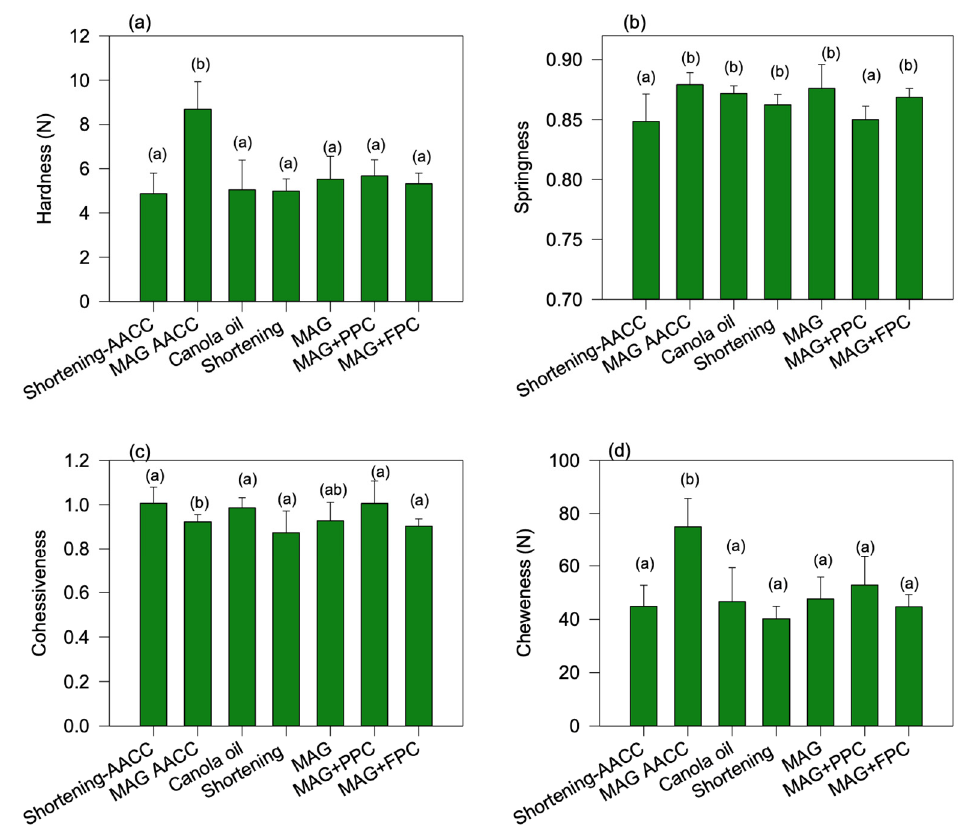
Figure 10. Texture analysis of different cakes measured 24 h after baking at room temperature: ( a ) hardness, ( b ) springiness, ( c ) cohesiveness, and ( d ) chewiness of cakes prepared using various fats with either AACC or the new lab-developed method. AACC method: Shortening-AACC, MAG oleofoam-AACC. The new lab-developed method: canola oil, shortening oleofoam, 3%MAG oleofoam, 3%MAG+PPC oleofoam, and 3%MAG+FPC oleofoam. MAG, monoacylglycerols; PPC, pea protein concentrate-stabilized foam; FPC, faba bean protein concentrate-stabilized foam.